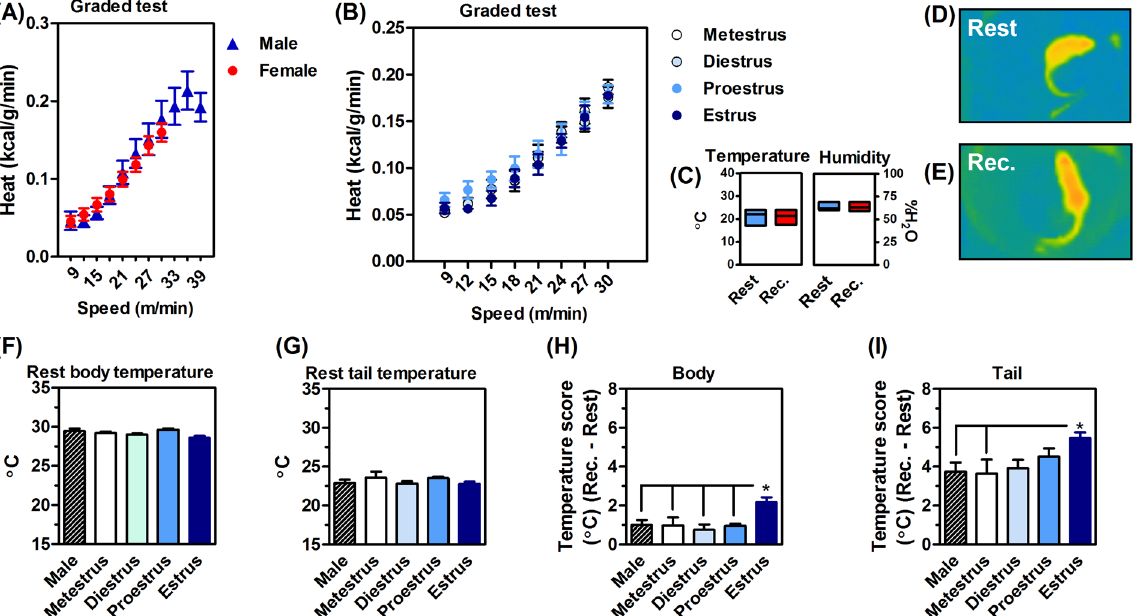
Figure 4. Exercise heat production and dissipation, or thermoregulation. Upon exercise, male and female mice consumed similar calories during the incremental test ( A ) without any evident impact of the estrous cycle. ( B ) Experiments were conducted in a controlled temperature and humidity environment. ( C ) The thermal IR image shows an evident tail heating after the maximum exercise (or recovery time, REC, E ) in relation to rest. ( D ) The body and tail temperature was not different at rest ( F and G , respectively). Exercise warmed the body of females at estrus ( H ) and the tails of all groups of mice ( I ). Again, female tail heating was larger at estrous ( I ). Values are expressed as mean ± standard error of the mean (SEM). N = 8–10 animals/group. * P < 0.05 (ANOVA, Bonferroni post hoc